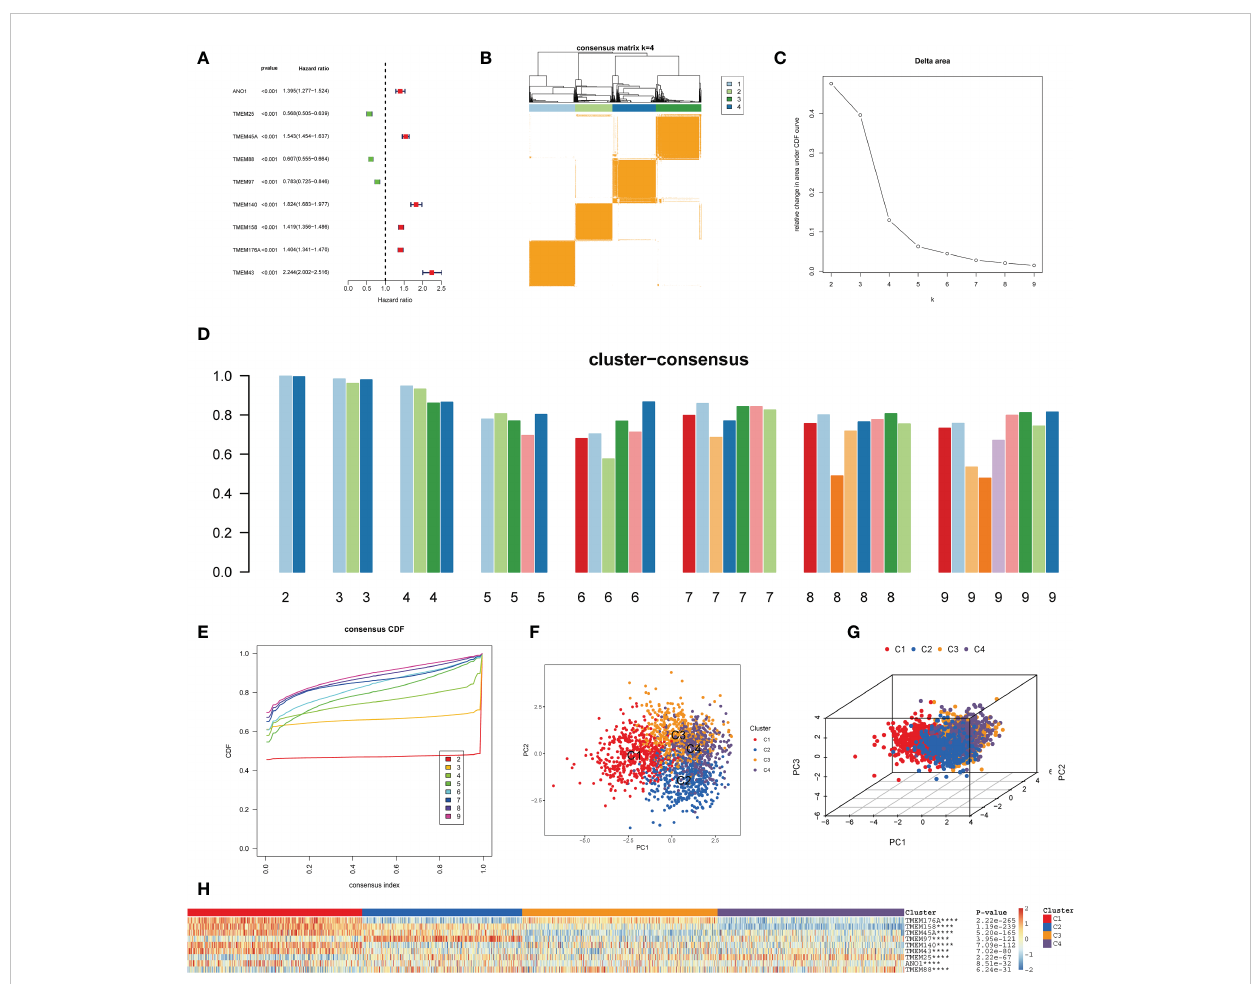
FIGURE 2 Identi fi cation of transmembrane protein-related subtypes. (A) Forest plot of nine prognostic transmembrane protein-related genes in glioma based on the univariate Cox regression analysis. (B) Subgroups of glioma de fi ned by nine prognostic transmembrane protein-related genes. The 4 cohorts